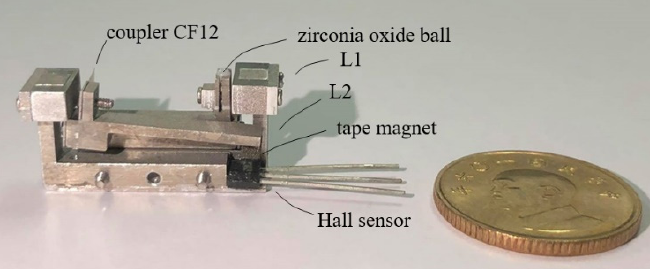
Figure 24. A prototype of the compact model, with an overall dimension of 25 mm × 11 mm × 12 mm.